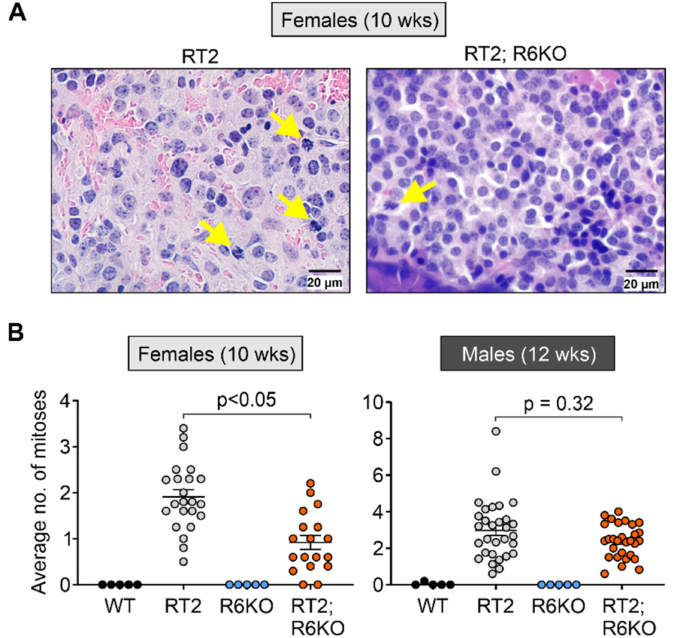
Figure 5. Loss of RABL6A reduces islet cell mitoses in RT2 mice. Mitoses were counted on 3– 6 random fields of view within an islet at 600 × magnification and their average was calculated. ( A ) Representative images of RT2 and RT2; R6KO islet sections. Arrows indicate mitoses. Scale bar = 20 µ M. ( B ) The average number of mitoses (per field) is significantly reduced in the transformed islets of 10-week-old RT2; R6KO females (left) compared to age-matched RT2 females. Data are the mean +/ − SEM with each dot representing an average number of mitoses per field of vision for an individual islet. N = Females (WT = 5, RT2 = 5, R6KO = 5, RT2; R6KO = 5); Males (WT = 5, RT2 = 7, R6KO = 5, RT2; R6KO = 6). Linear regression was used to compare average number of mitoses between